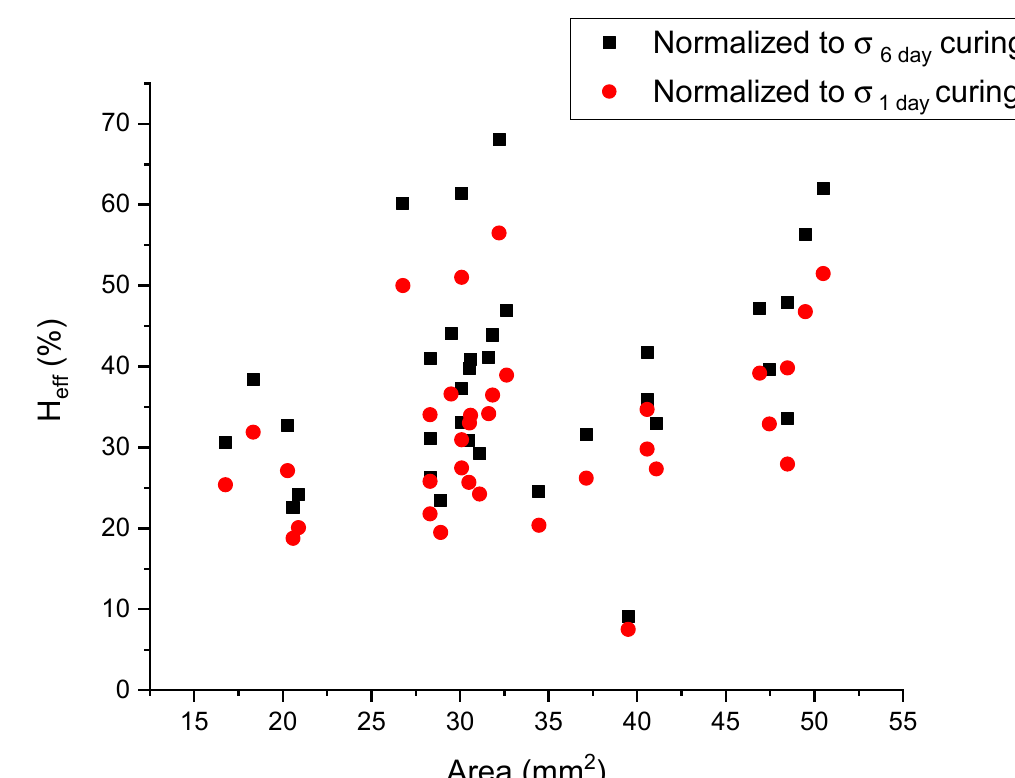
Figure 6. Area-dependency of the healing efficiency. All measurements were performed for six days at 100 °C (the average standard deviation is SD σ 6 day = 17.14% and SD σ 1 day = 13.76%).